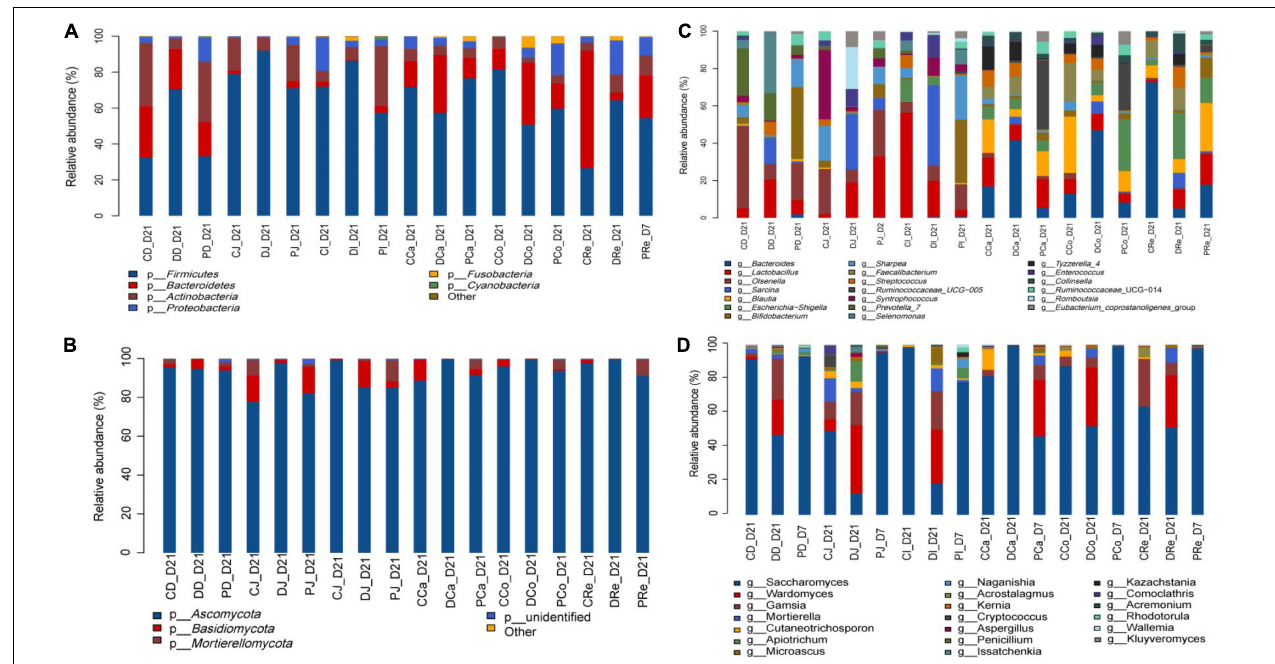
FIGURE 2 | Composition of the different gut region digesta-associated microbial community. (A,C) Show the composition of the microbial community in the three groups (C, D, and P) with respect to bacterial phyla and genera. (B,D) Show the composition of the microbial community in the three groups (C, D, and P) with respect to fungal phyla and genera (CD, DD, and PD represent groups C, D, P dudenum; CJ, DJ, and PJ, represent groups C, D, P jejunum; CI, DI, and PI represent groups C, D, P ileum; CCa, DCa, and PCa, represent groups C, D, P cecum; CCo, DCo, and PCo, represent groups C, D, P colon; CRe, Dre and PRe, represent groups C, D, P rectum).